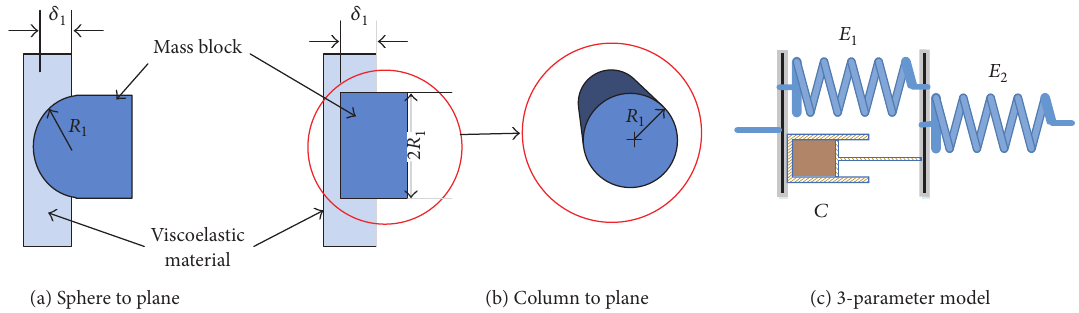
Figure 4: Schematic of contact geometries and 3-parameter viscoelastic model.